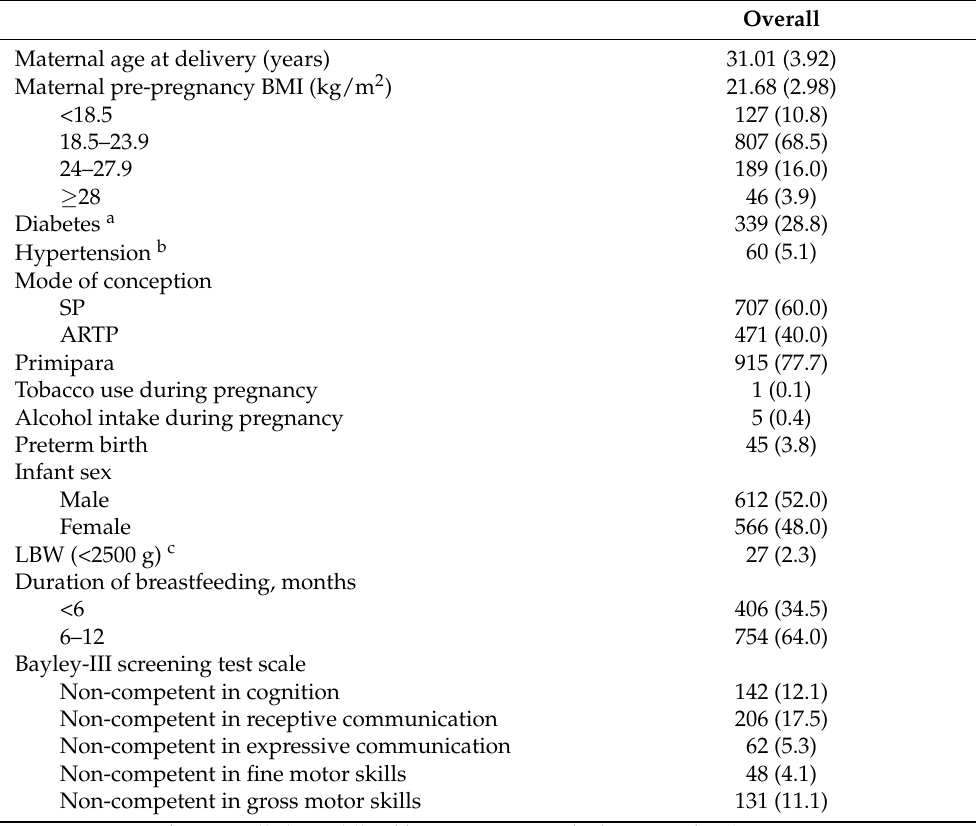
Table 1. Descriptive characteristics of baseline demographic and lifestyle factors of 1178 mother– infant pairs